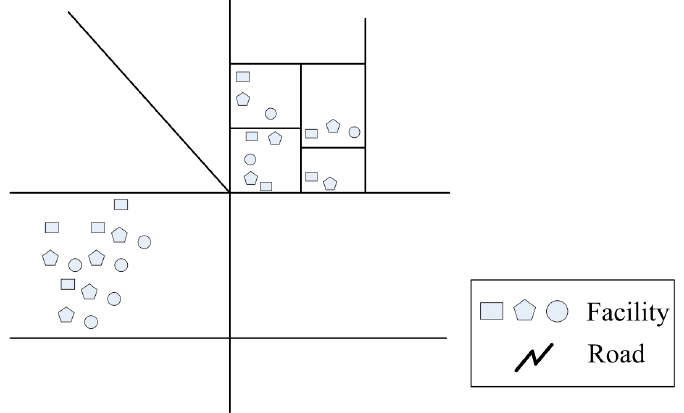
Figure 4. An illustration that facilities gather in different blocks due to their own spatial interactions (the lower-left block) or to the street network accessibility advantage (the upper-right